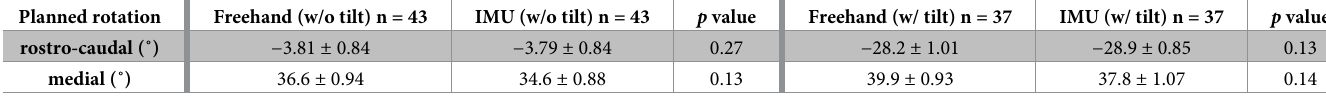
Table 1. Average planned rotational angles of the freehand and IMU-assisted groups with or without rostral tilt of the samples. Planned rotation